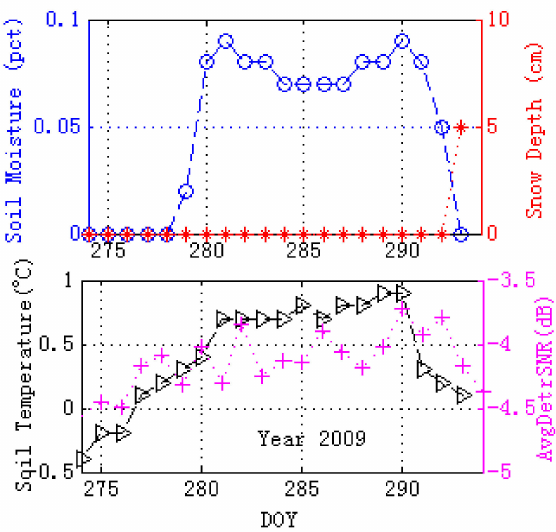
Figure 8. Comparisons between GPS site (AB33) and SNOTEL site (ID 958) from DOY 270 (2009) to DOY 295 (2009). The elevation angle is 20 ◦ . The upper panel presents the comparisons of soil moisture (blue O) and snow depths (red *). Comparisons of soil temperature (black (cid:52) ) and ADSNR (pink +) are presented in the bottom